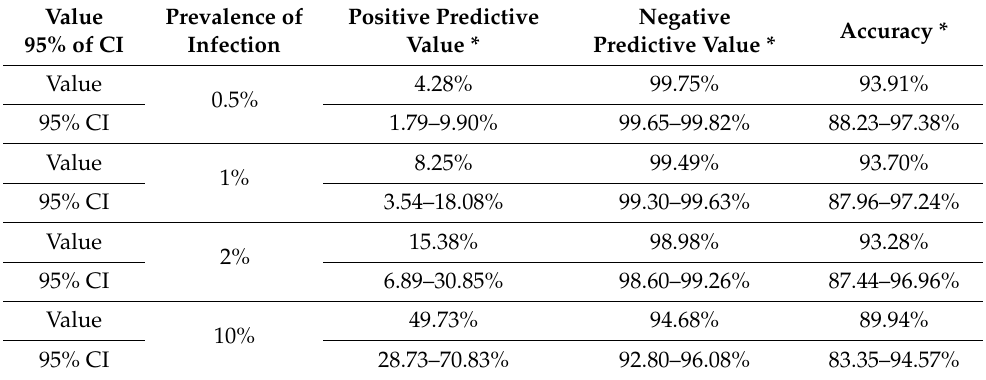
Table 7. Simulation of Positive Predictive Value, Negative Predictive Value and accuracy based on prevalence.